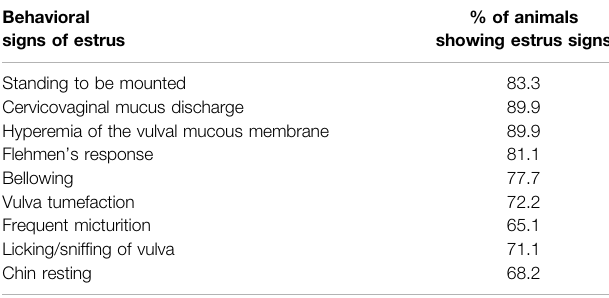
% of animals showing estrus signs